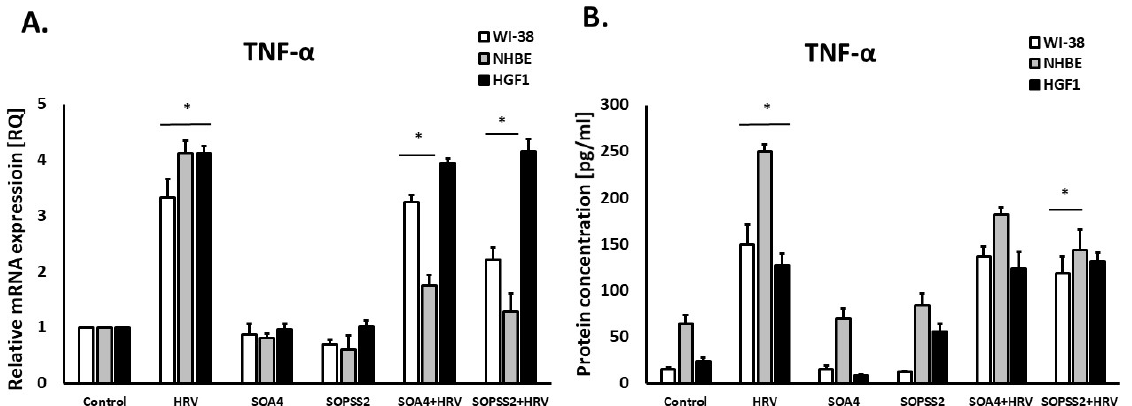
Figure 3. TNF- α expression in WI-38, NHBE and HGF-1 cells after treatment with SOPSS2 and SOA4 extracts from Senna obtusifolia under the conditions of HRV-16 infection. ( A ) mRNA and ( B ) protein level of TNF- α expression. Extracts from transformed (SOA4) and transgenic (SOPSS2) Senna obtusifolia hairy roots. Data presented as mean ± SEM, * p < 0.05.